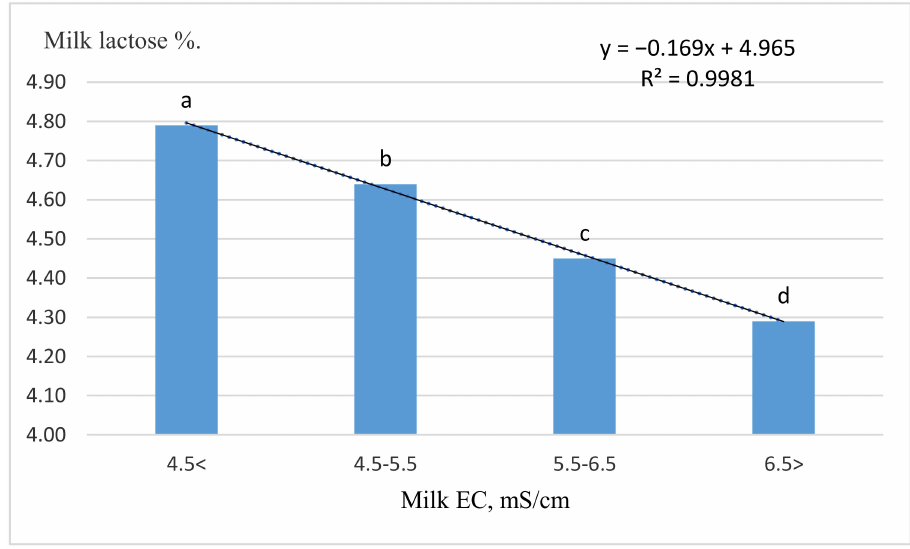
Figure 2. Milk lactose by milk EC level. EC = milk electrical conductivity. a, b, c. d — p <